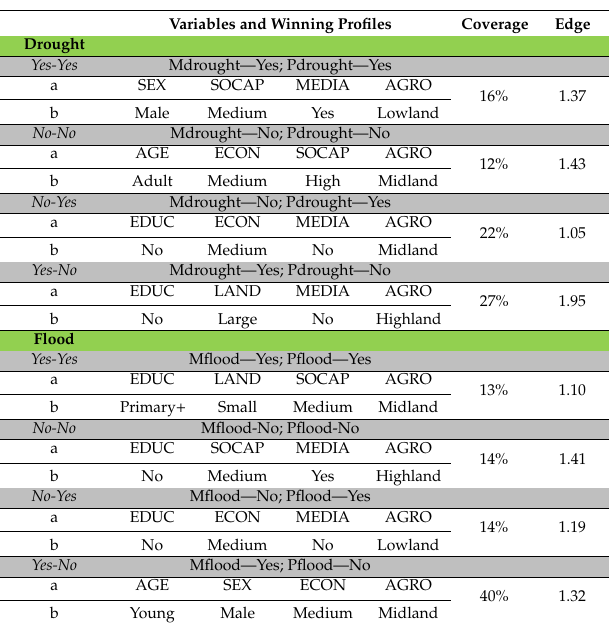
Table 8. Winning profiles of convergence and divergence between measurement and farmers’ perceptions of the occurrences of drought and flood.